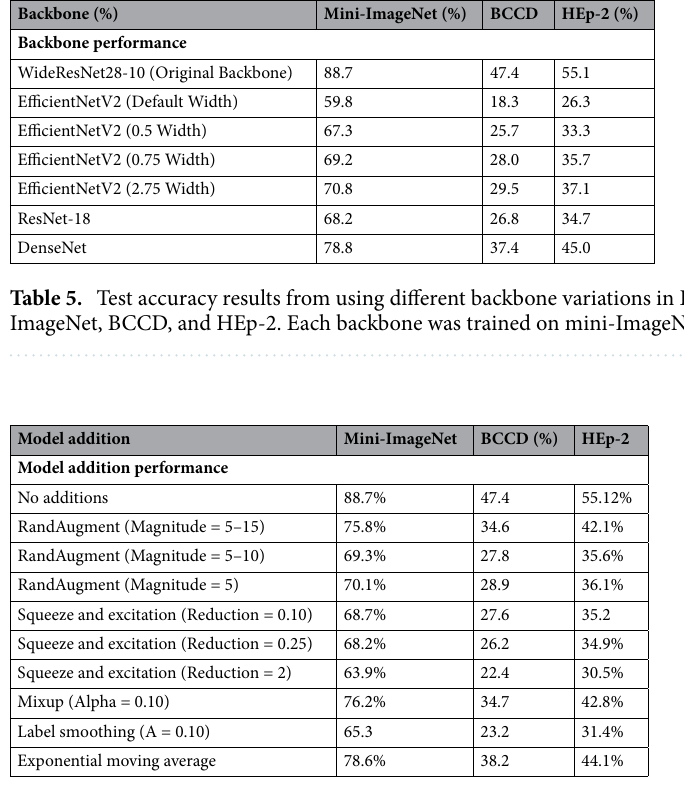
Table 6. Test accuracy results using different model additions within EPNet. Each model addition was independently trained on the mini-ImageNet training set and tested on the mini-ImageNet test set, BCCD, and HEp-2.